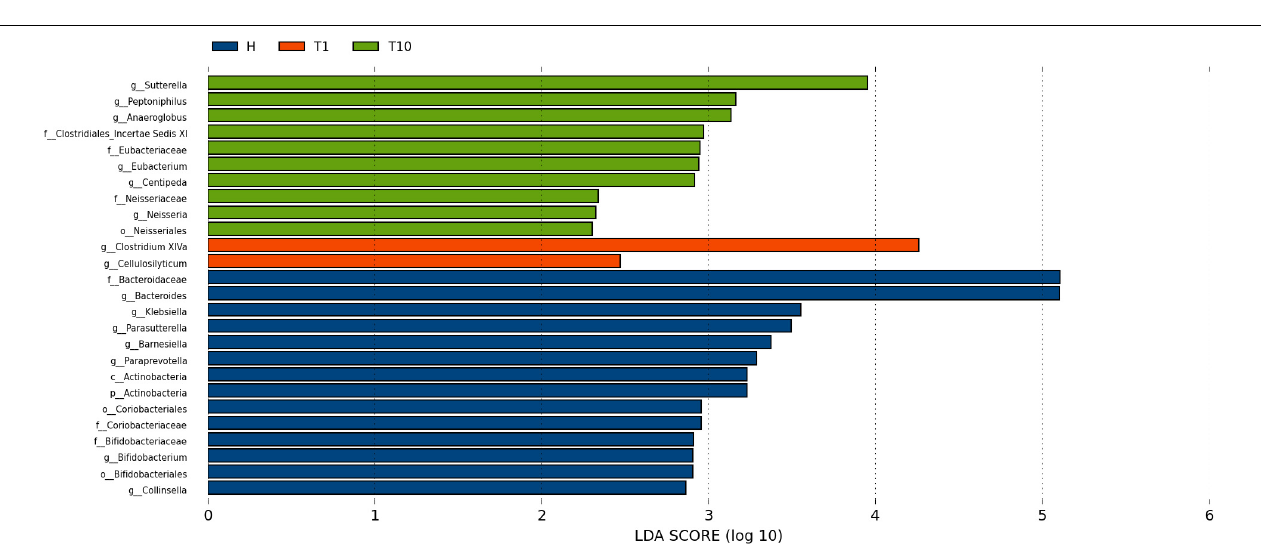
that indirectly promote rectal cancer. However, there were no significant differences in intestinal microbiota between NSCLC patients and healthy individuals and between pre-therapy